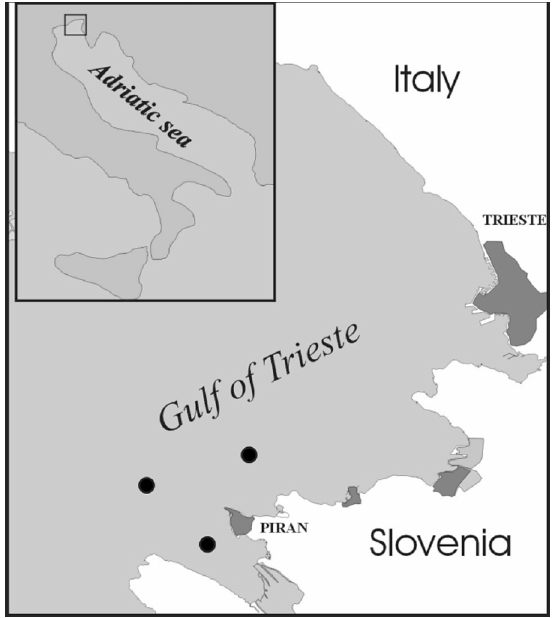
Fig. 1. Map of the studied area with sampling sites where Mustelus punctulatus , were caught from June